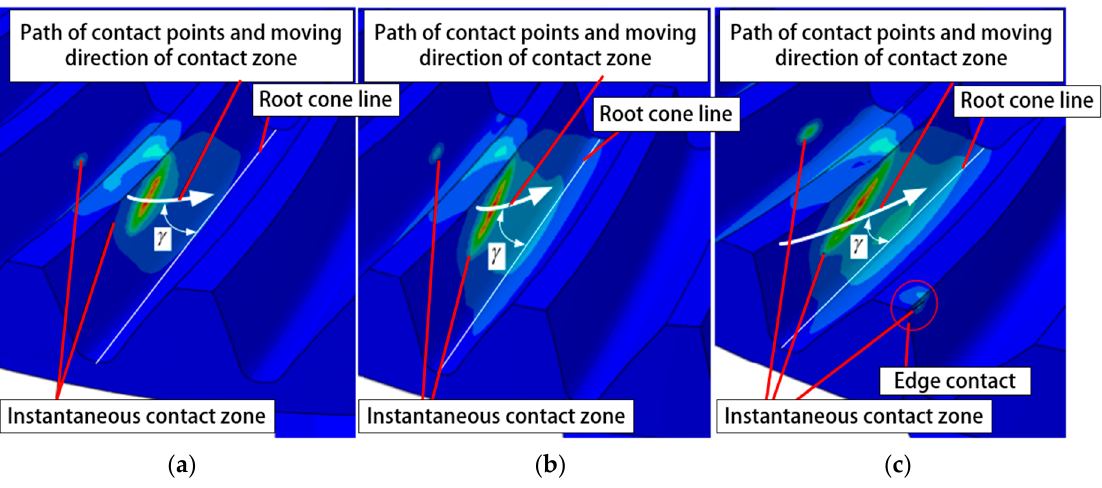
Figure 10. Comparison of loaded contact zone of the gear convex face: ( a ) Load T = 500 Nm, ( b ) Load T = 1500 Nm, and ( c ) Load T = 4500 Nm.